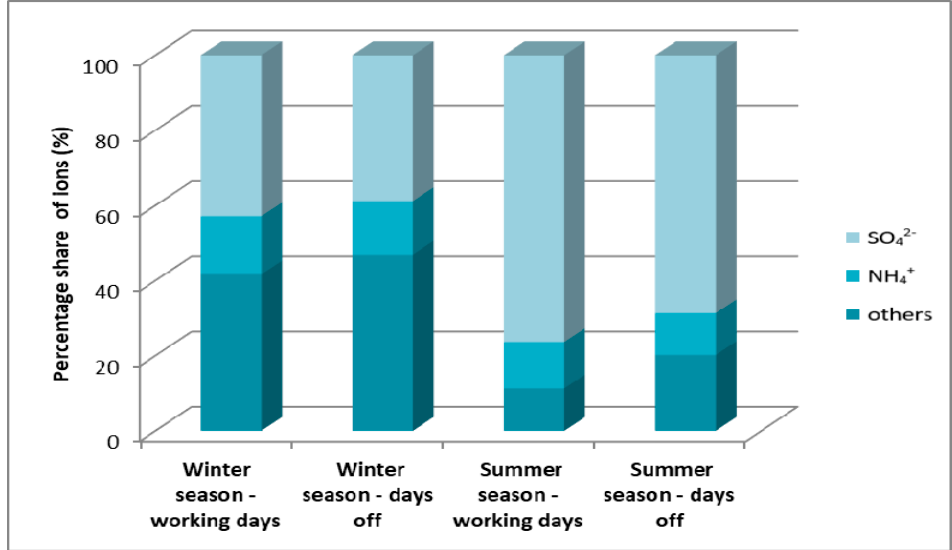
Figure 11. Percentage of cations and anions in the total content of ions associated with fine particles on winter and summer working days and weekends in Zabrze in 2009 [22].